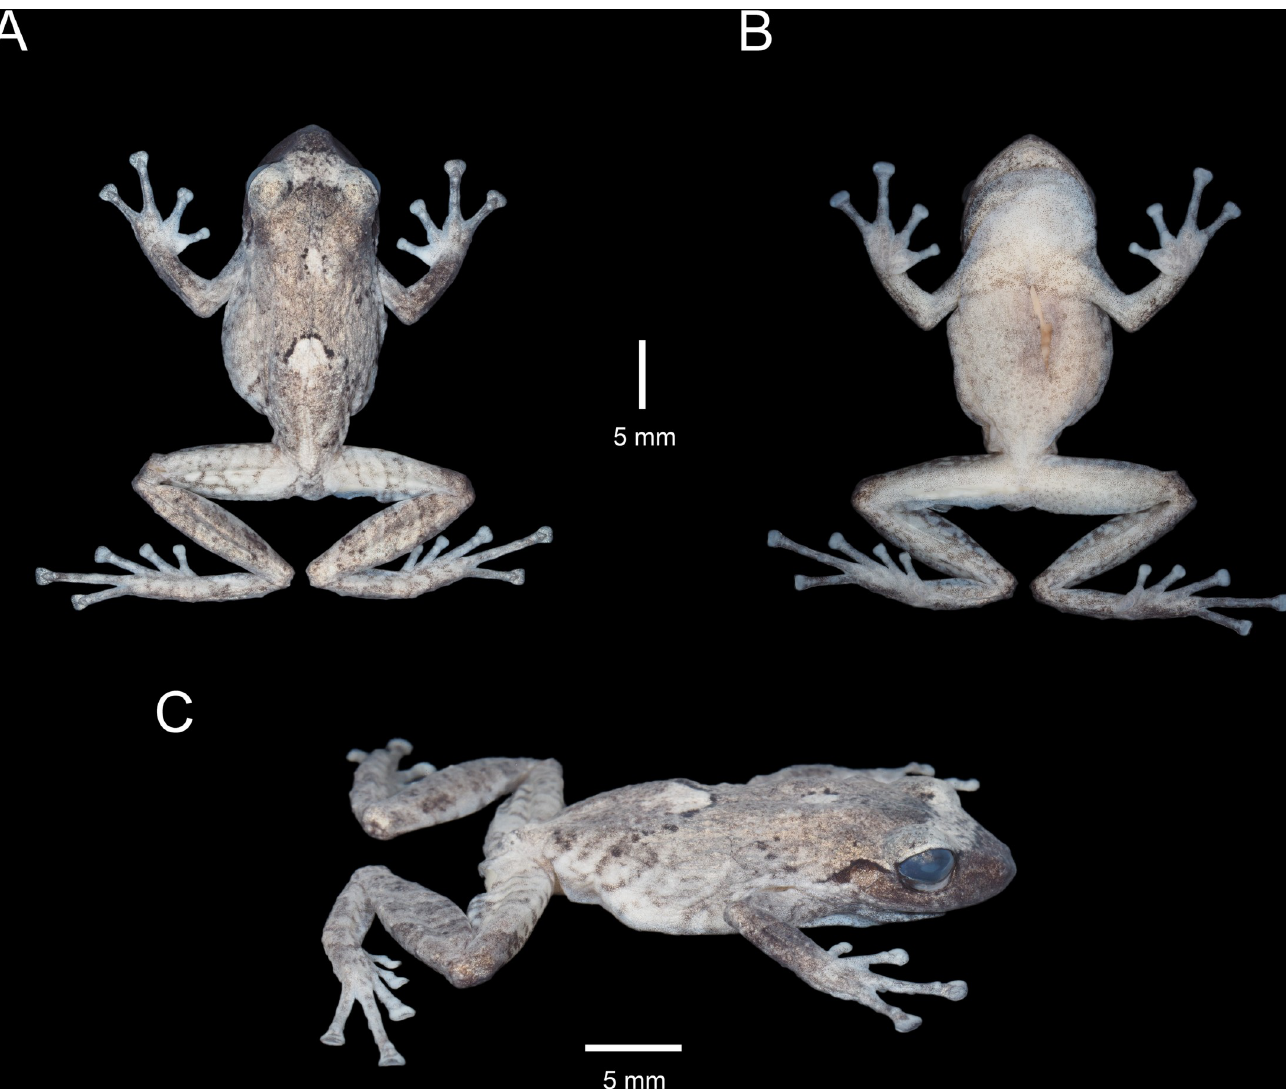
Fig 4. Paratype of Pristimantis lojanus sp. nov. (MUTPL 1030, adult male), SVL 28.5 mm, in preservative. A. Dorsal view; B. Ventral view; C. Lateral view.